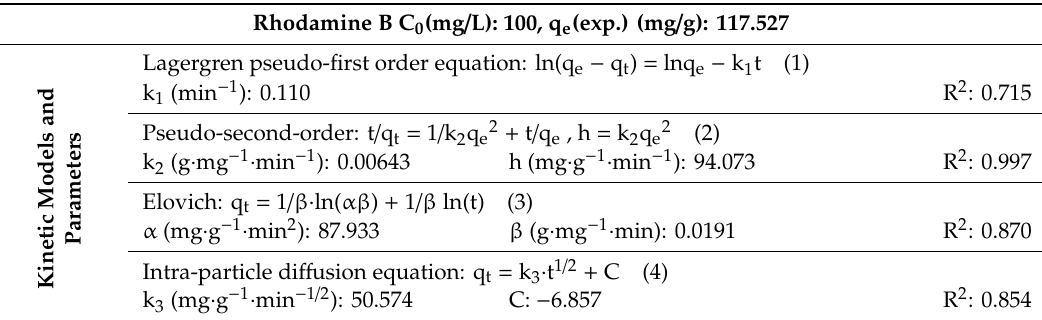
Table 1. Mathematical equations in RhB adsorption kinetics and kinetic parameters of various models fitted to experimental